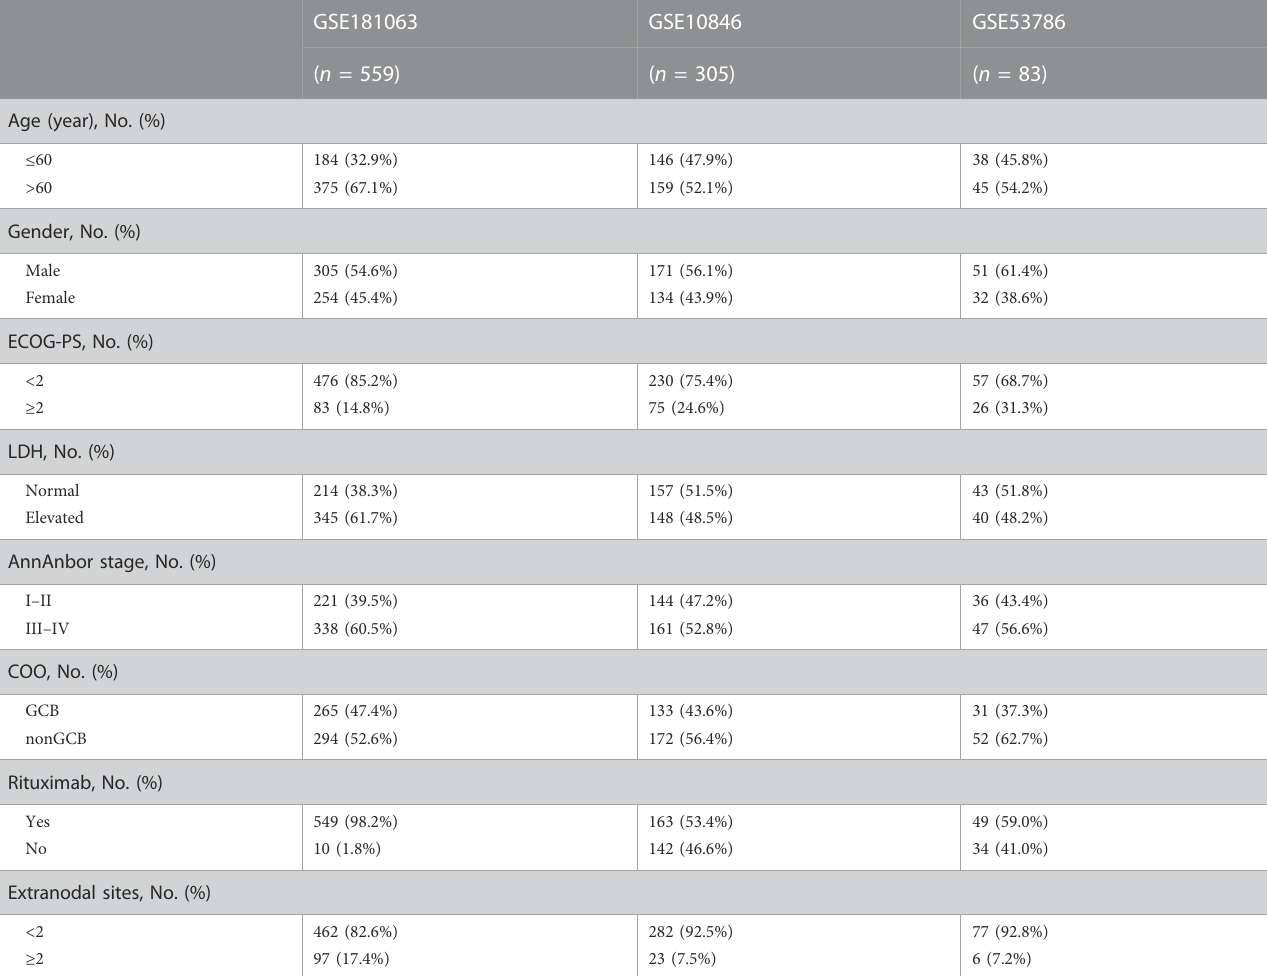
TABLE 1 Clinicopathological characteristics of patients with DLBCL enrolled from the GEO